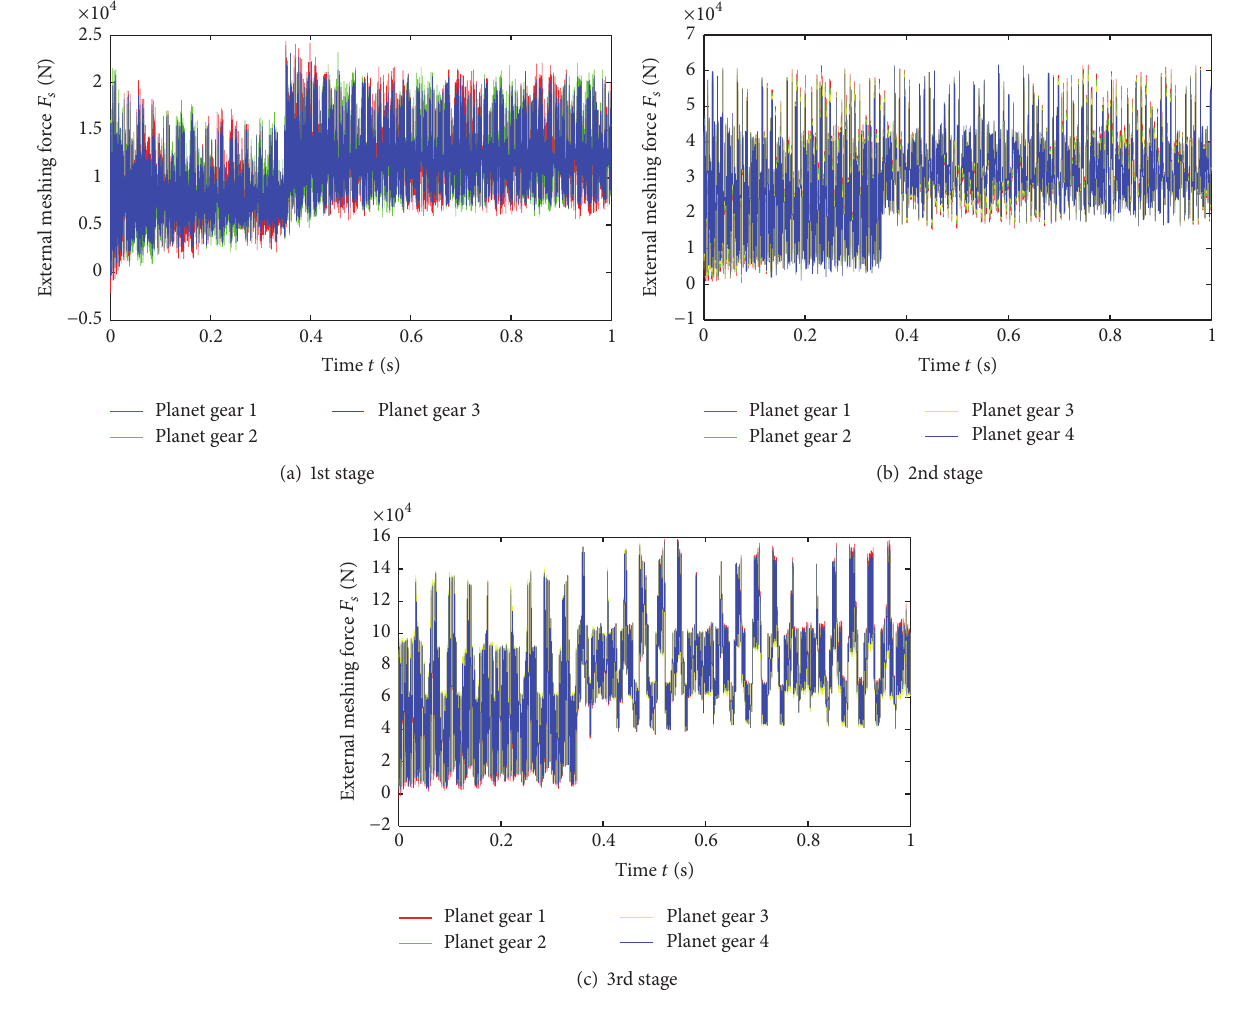
Figure 12: External meshing force in time